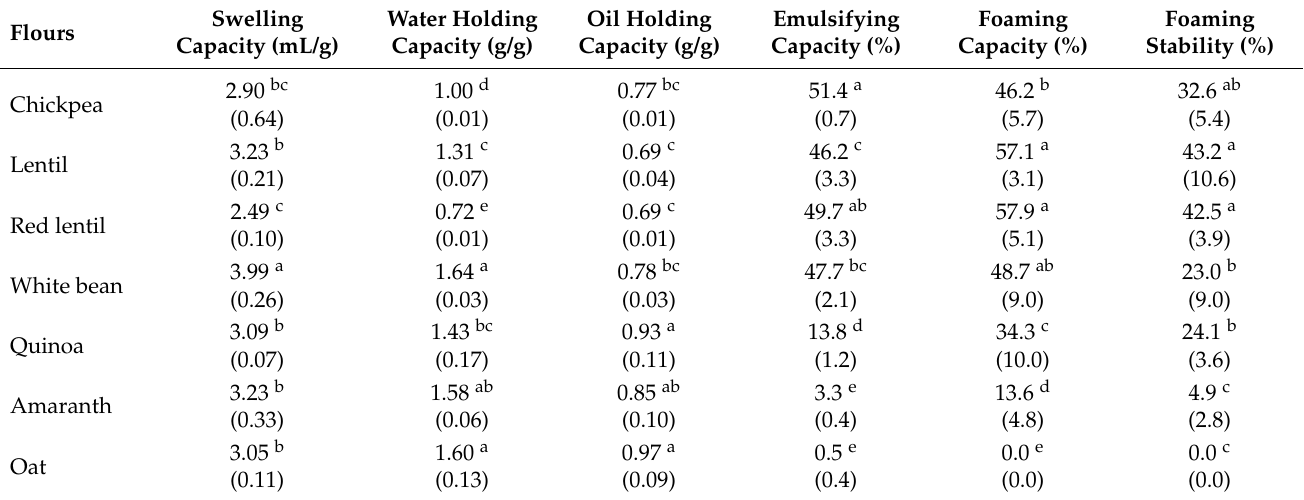
Table 3. Mean values of the techno-functional properties of flours. Standard deviation in